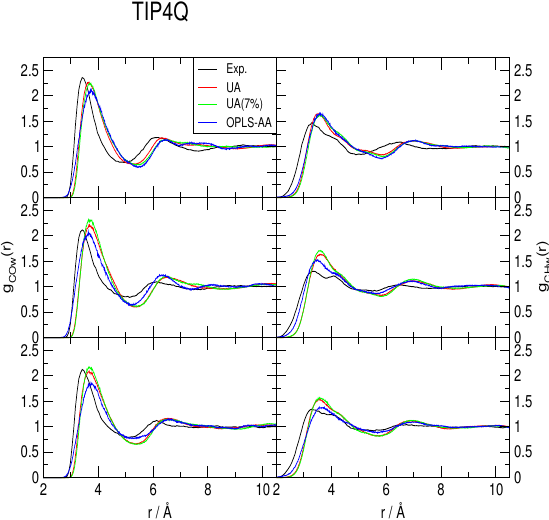
Figure 4. Comparison to the experimentally determined [34] methane-water radial distribution functions of those obtained from simulations with the TIP4Q water model at 277 K ( top ), 283 K ( middle ) and 291 K ( bottom ), all under a pressure of 145 bar. UA: United-atom model from Reference [41]; UA (7%): Same model with a 7% correction for the C − O interaction; OPLS-AA: All-atom force-field from Reference